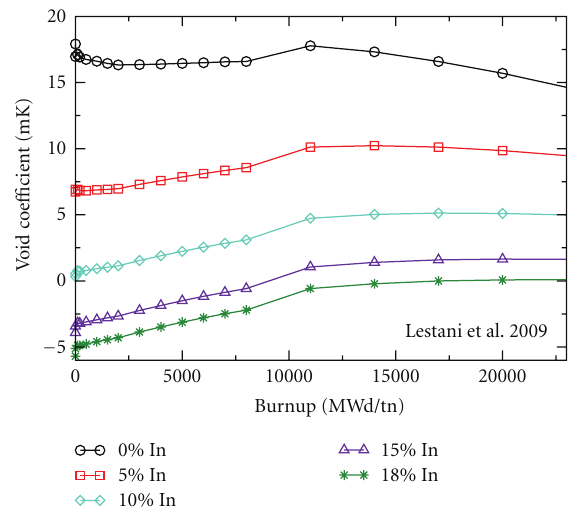
Figure 6: Gd isotopes weight percent evolution with burnup.